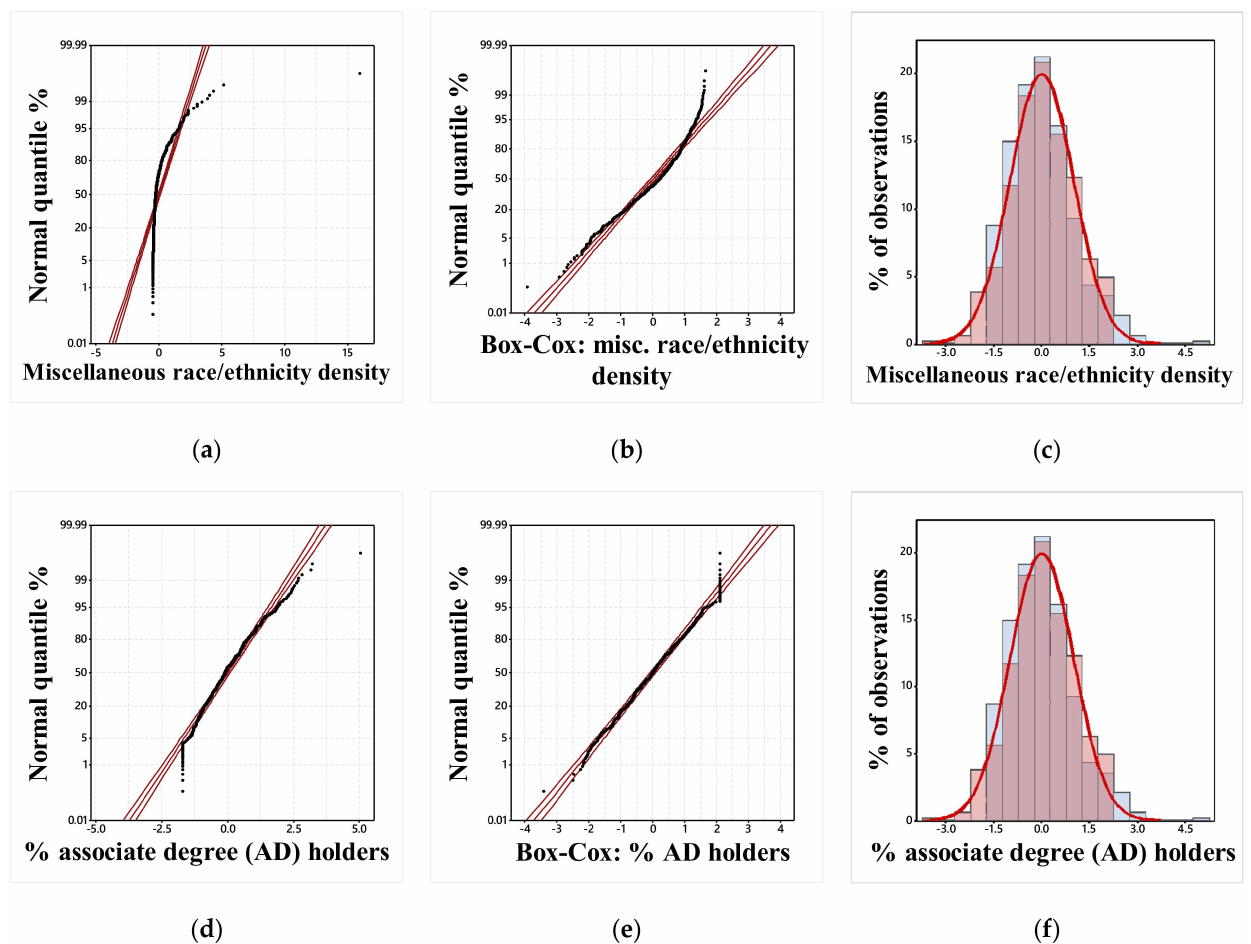
Figure 2. Normal quantile (red lines denote 95% confidence intervals and trendlines) and his- togram portrayals for two Box–Cox power transformation extreme cases appearing in Table 5. Top left ( a ): raw DC% associate degree holders. Top middle ( b ): Box–Cox transformed raw DC% associate degree holders. Top right ( c ): overlaid DC% associate degree holder variates with superimposed bell-shaped curve. Bottom left ( d ): raw DC% associate degree holders. Bottom middle ( e ): Box–Cox transformed raw DC% associate degree holders. Bottom right ( f ): overlaid DC% associate degree holder variates with superimposed bell-shaped